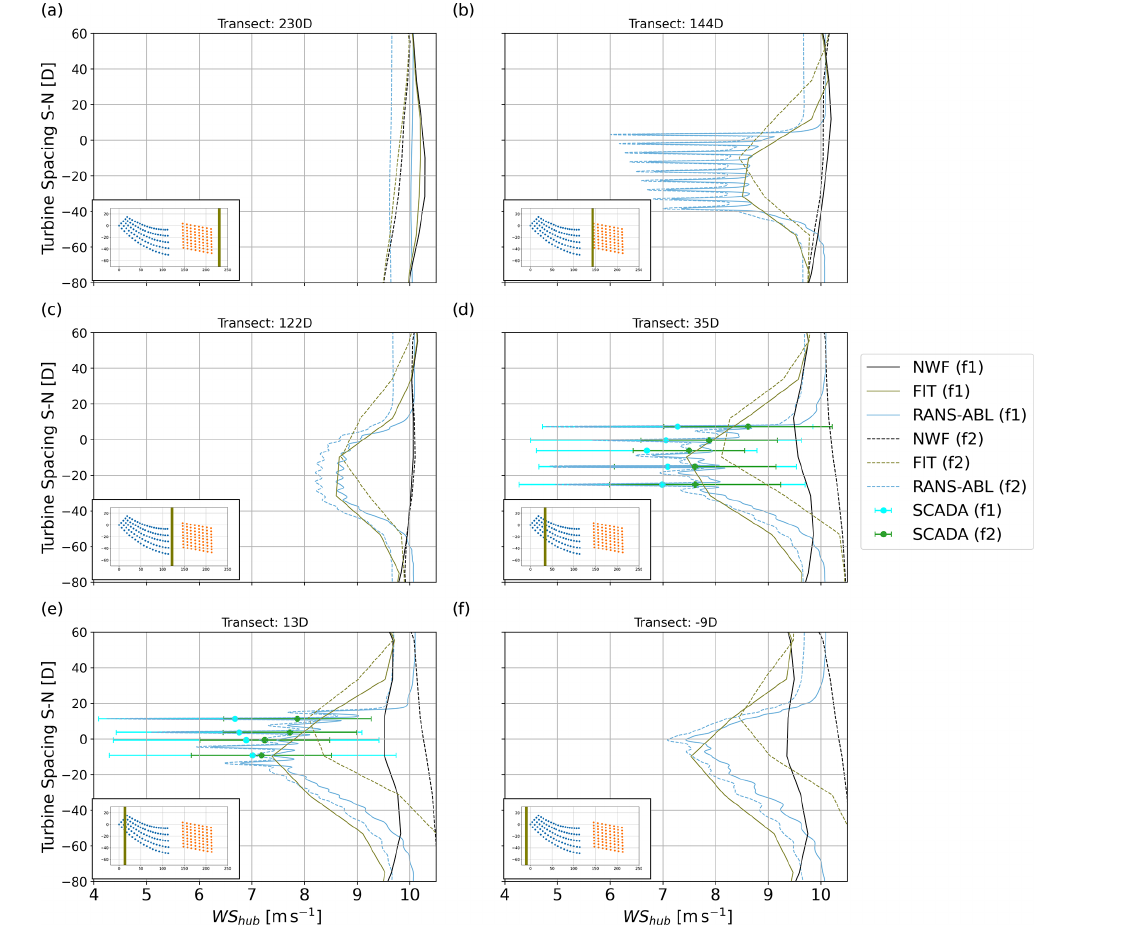
Figure 11. North–south transects for wind speed at hub height for different models at different locations in the east–west direction as indicated by the olive line in each subplot and the transect name in the title in normalized coordinates as explained in the text. All simulations are for NYRØ. For abbreviations see Tables 5 and 7, and see Table 6 for the f1 and f2